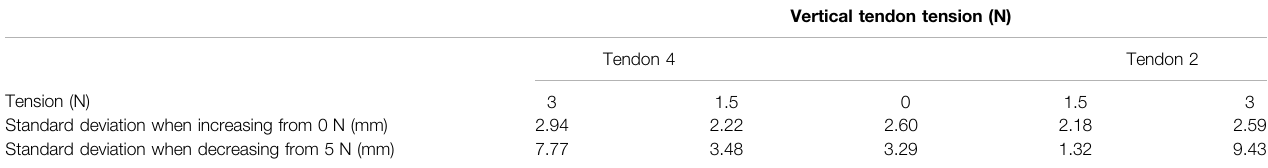
TABLE 1 | Standard deviation of the backbone tip location for different tensions when increasing from 0 N or decreasing from 5 N.